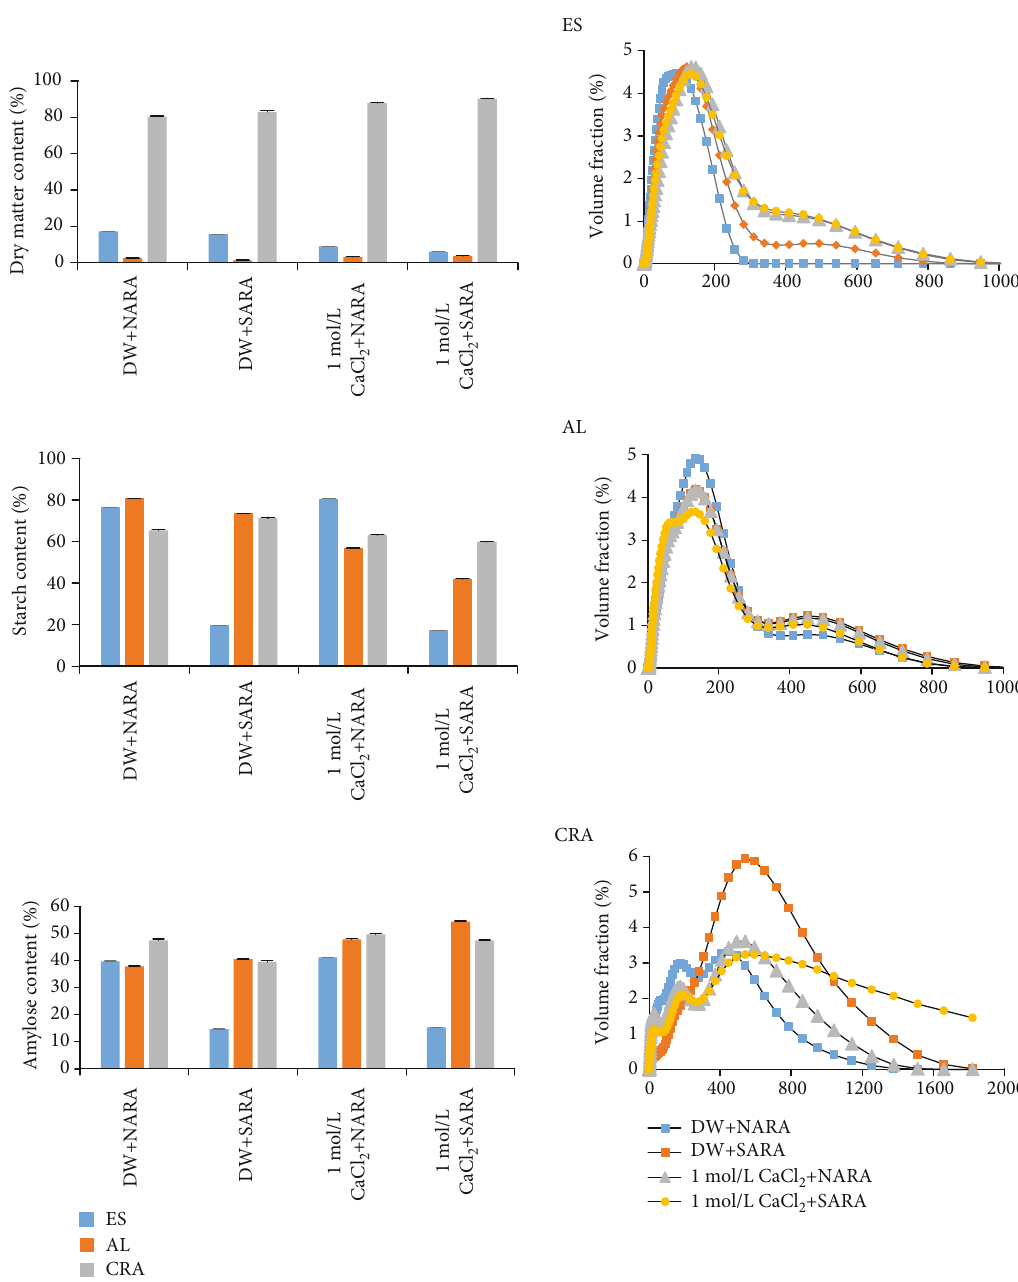
Figure 2: Physicochemical properties of rice analogues. ES: substances escaping from rice analogues; AL: adhesive layer on the cooked rice analogues; CRA: cooked rice analogues; DW: distilled water; NARA: rice analogues with nonadditive; SARA: rice analogues containing sodium